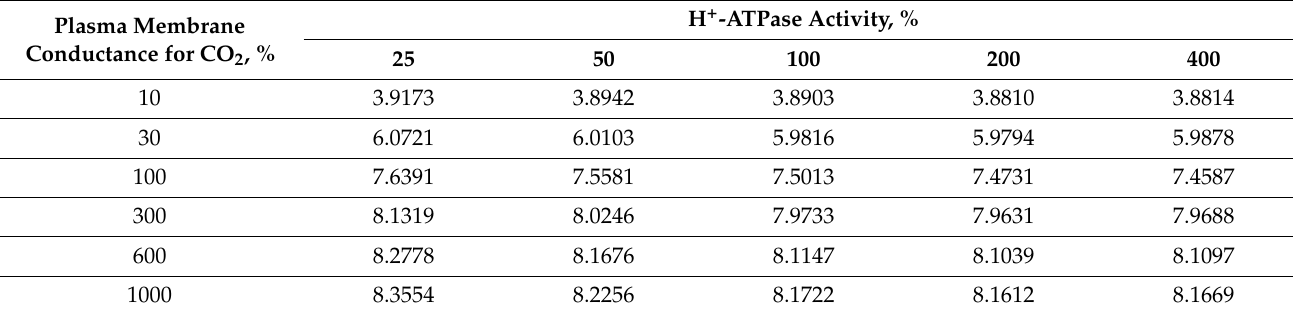
Table 2. Simulated dependence of CV(A hv ) on simultaneous changes in plasma membrane CO